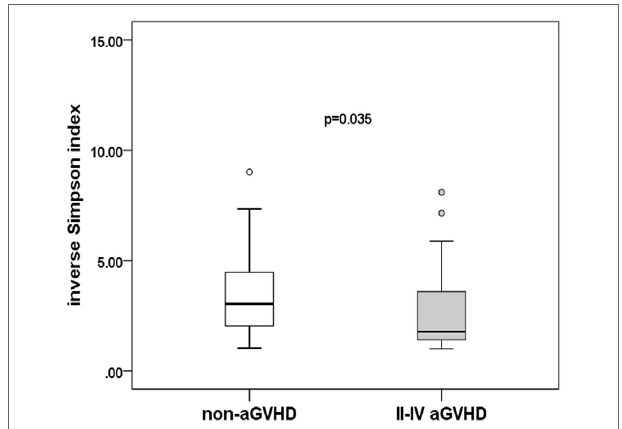
FigUre 1 | Difference of diversity in the intestinal microbiota. The intestinal microbiota diversity at engraftment is expressed as the inverse Simpson index according to the